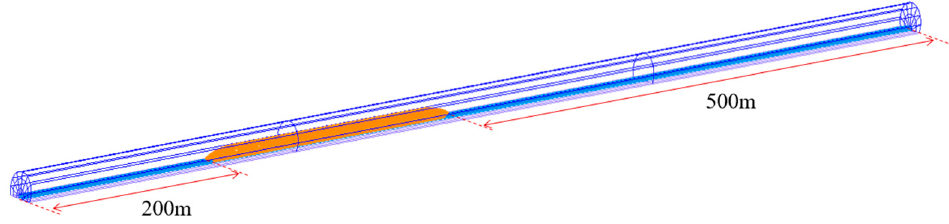
Figure 2. Computational model.